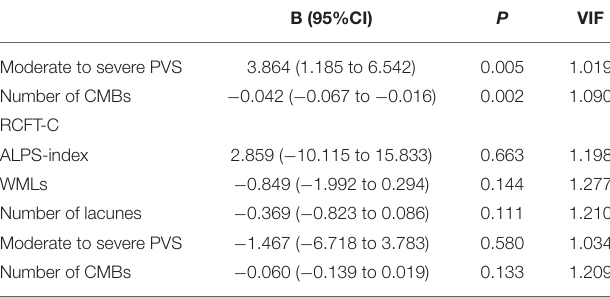
TABLE 4 | Multivariate regression linear analysis between neuropsychological test and imaging in CSVD.